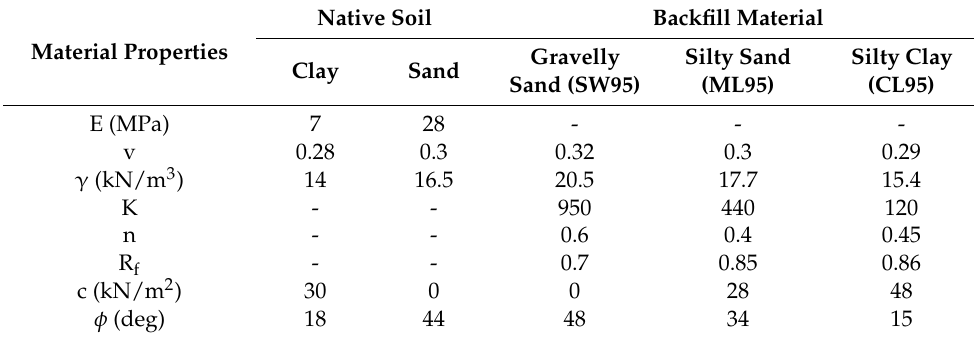
Table 1. Backfill and native soil properties. Material Properties